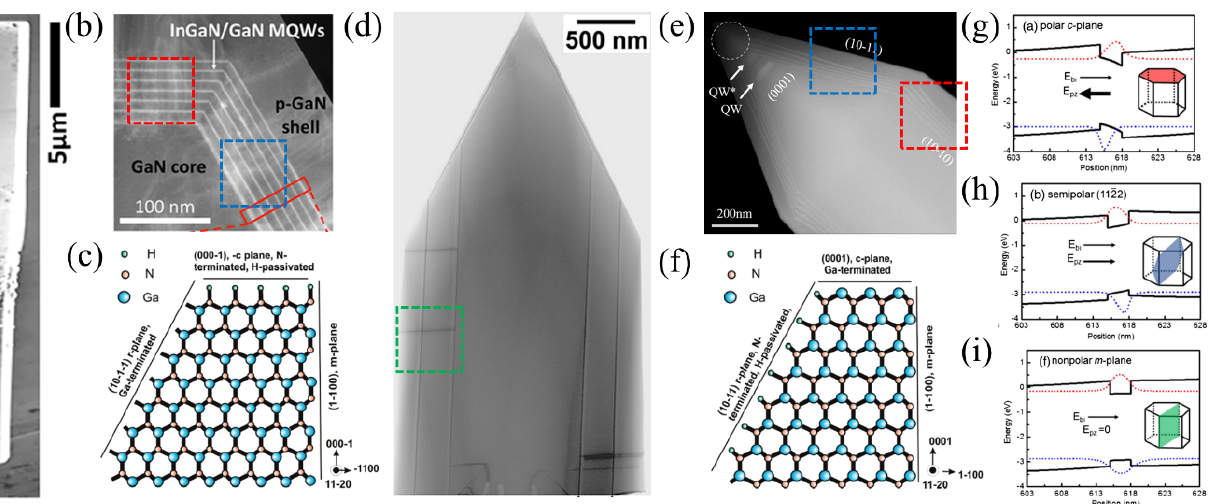
The Optical Society. The red and blue dotted lines illustrate the electron and hole wave functions, respectively.